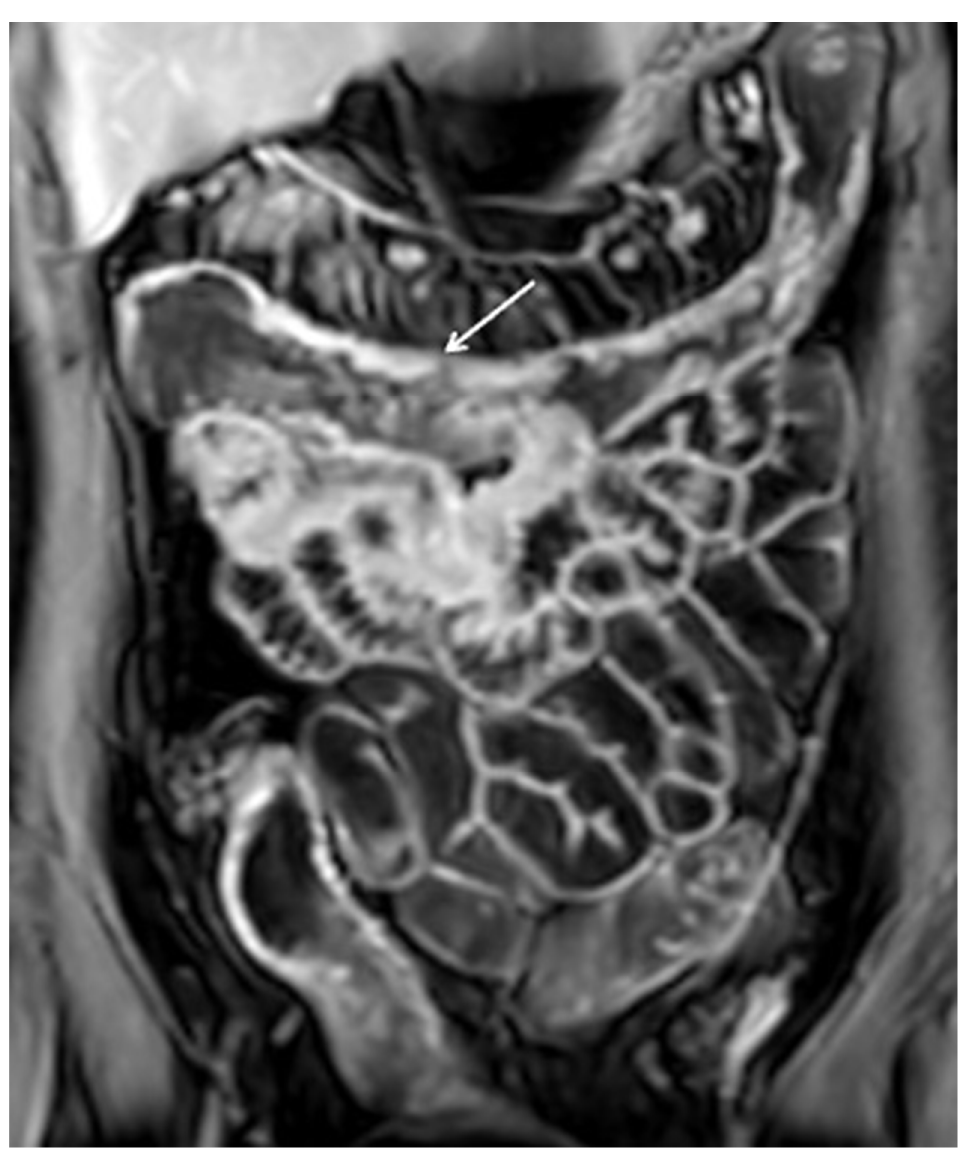
Figure 5. Ulcerations. Coronal contrast-enhanced fat-suppressed T1-weighted MRE portal venous phase image shows transverse colon with mural hyperenhancement and multiple intramural penetrating ulcers (white arrow), findings consistent with active inflammatory CD.